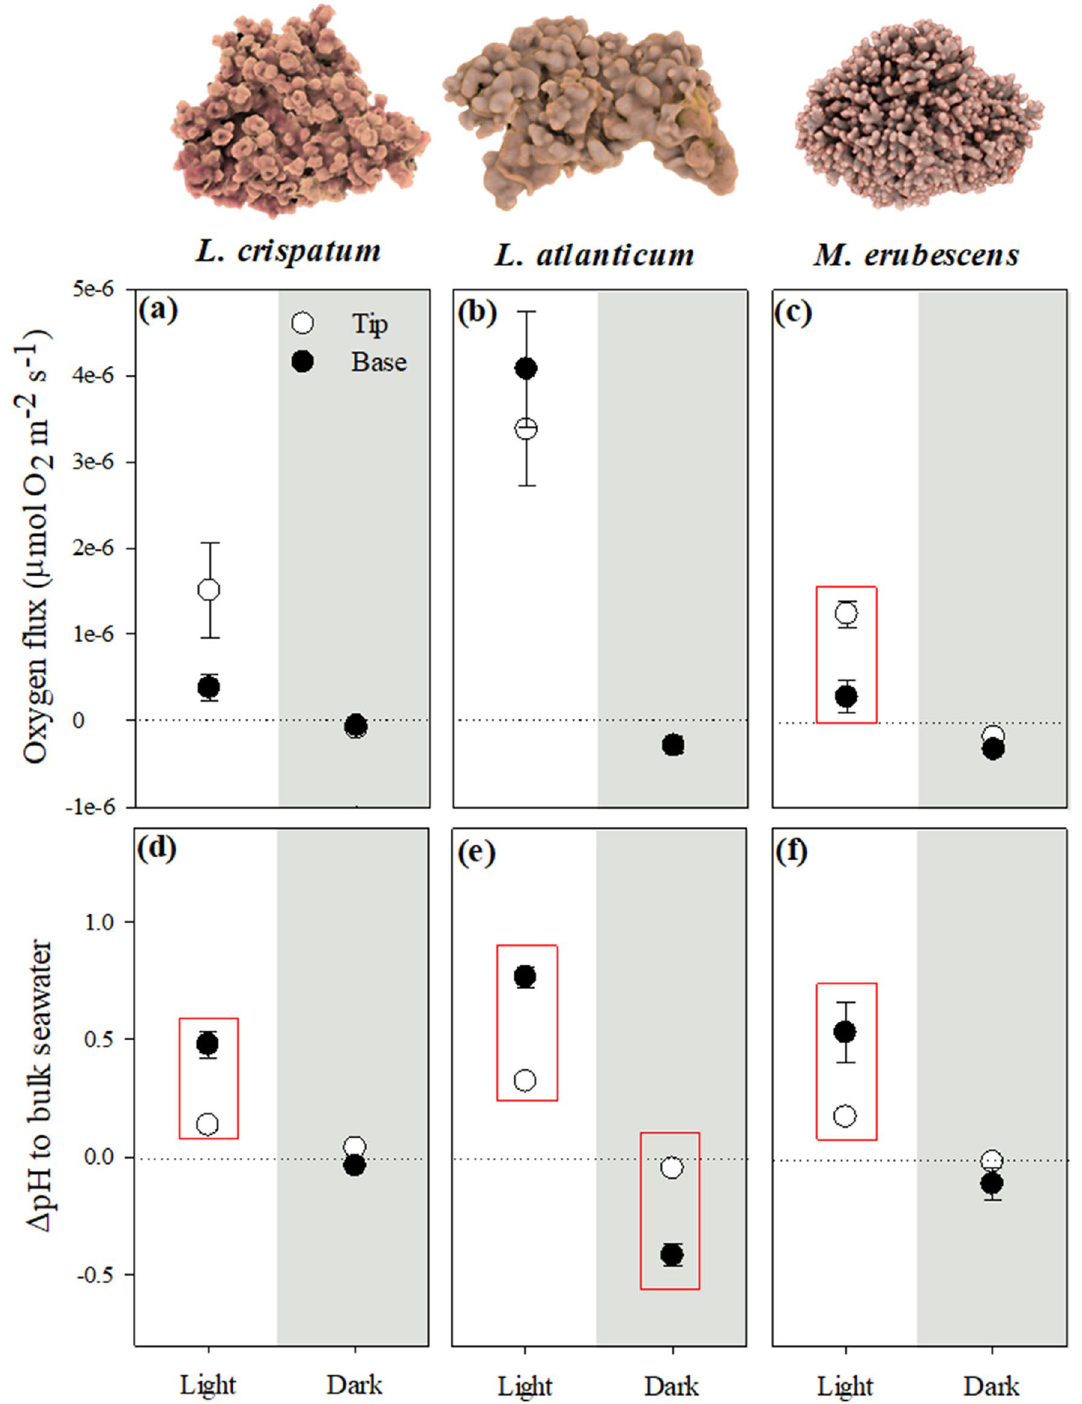
Figure 4. Effects of differences in rhodolith thallus surface topography (protuberance tip vs. base) on microscale oxygen and pH dynamics under light and dark conditions. ( a – c ) Species’ gross photosynthetic and respiratory rates and ( d – f ) the pH difference between thallus surface and bulk seawater. Data are shown as mean ± SE (n = 3) and red boxes indicate significant differences between tip and base for the respective species and light condition (ANOVA, Newman Keuls, p <